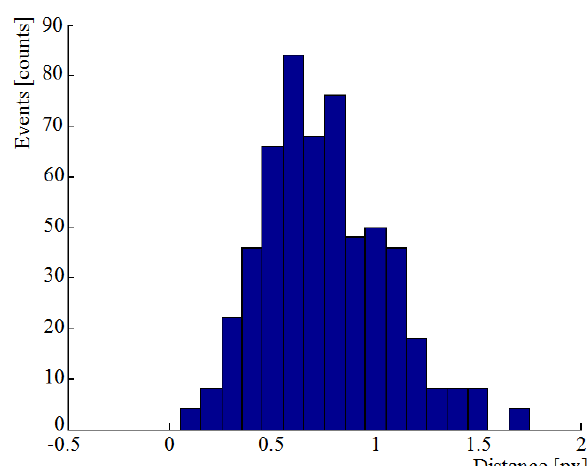
Figure 5. Histogram Euclidean distances between centroids computed by Gaussian fitting and Hough